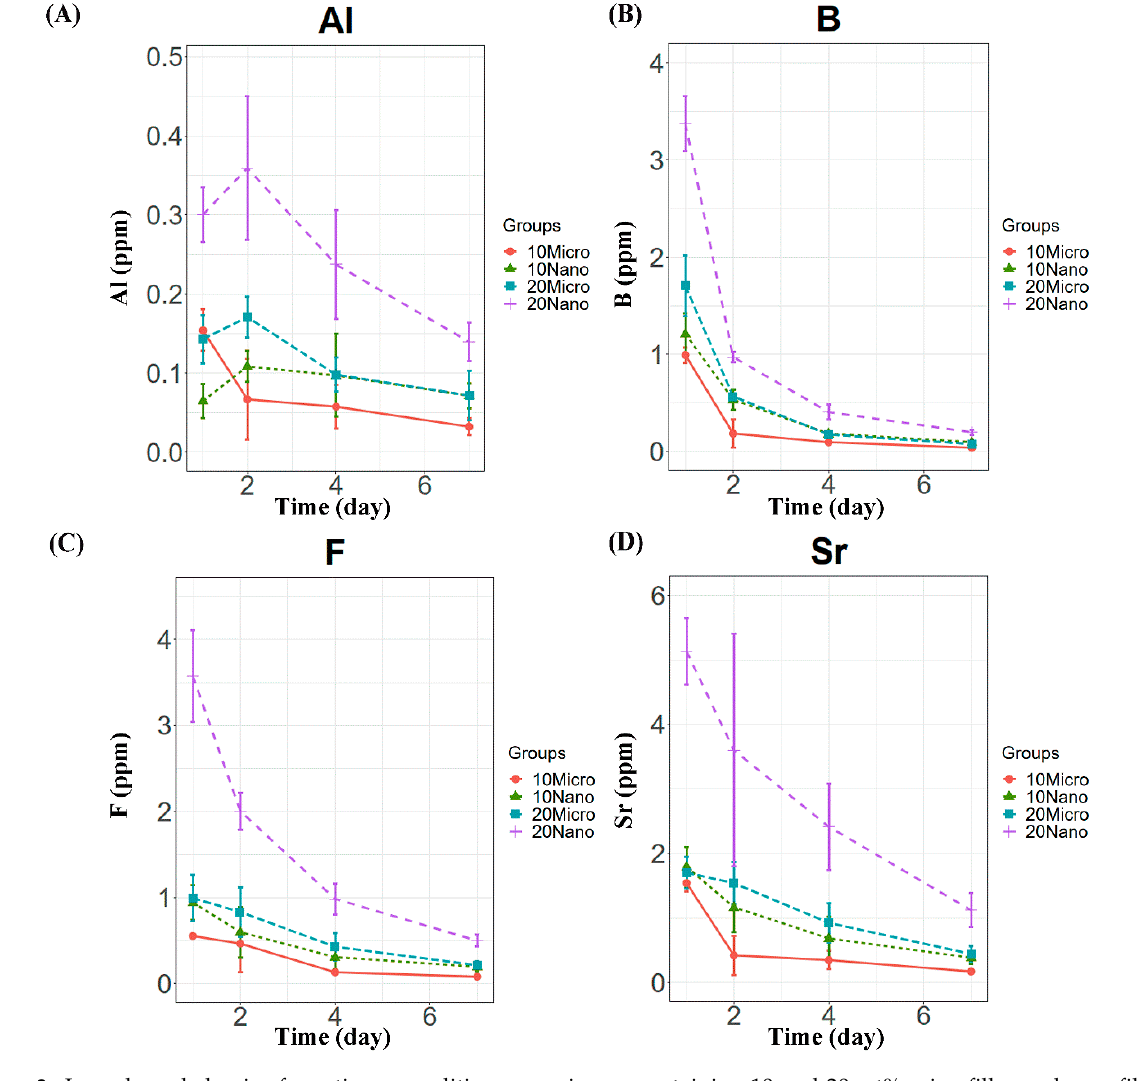
Figure 3. Ion release behavior from tissue conditioner specimens containing 10 and 20 wt% microfiller and nanofiller particles on days 1, 2, 4, and 7. Panels ( A – D ) show the Al, B, F, and Sr concentrations,